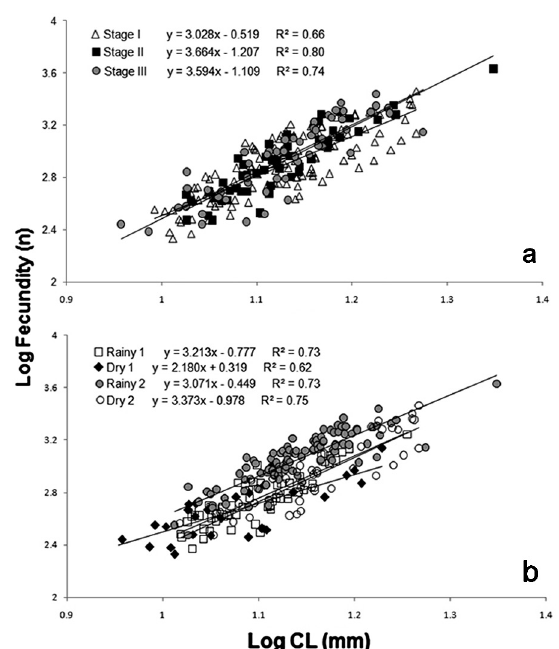
Figure 3 - Correlation between female size (CL) and fecundity of Macrobrachium amazonicum (Heller, 1862) from Tietê River, using as covariable: a ) egg stage; b ) year